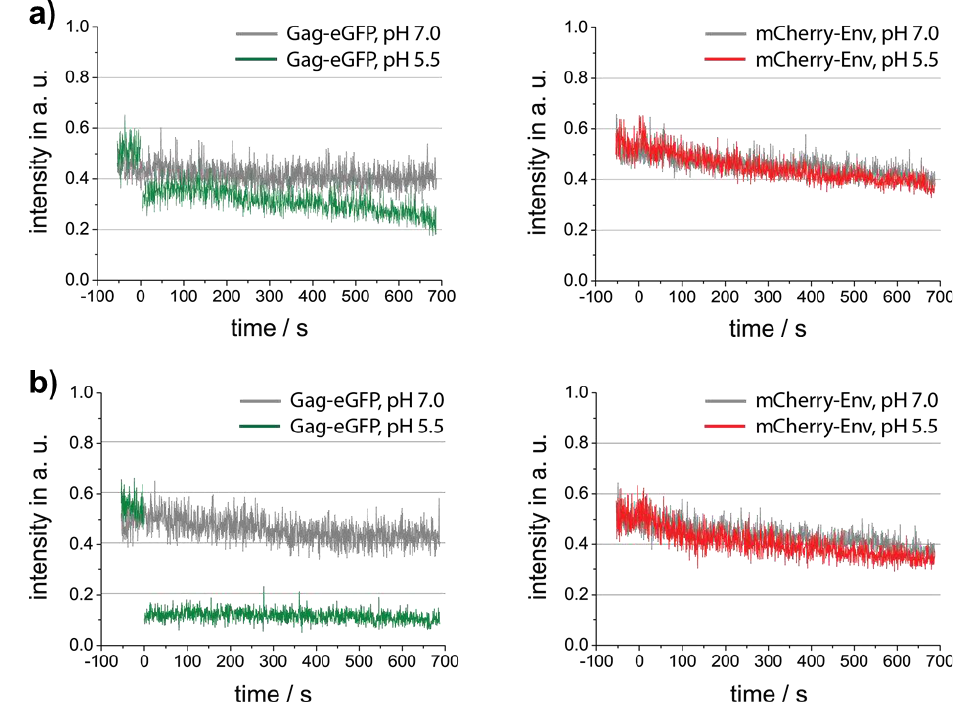
Figure A6. Stability of the fluorescent proteins on dual-color foamy virus particles at different pH values. Intensity traces of double-tagged PFV Env containing particles at pH 7.0 (gray) and pH 5.5 (green). At time point 0, citrate buffer was added to decrease the pH. The background-corrected intensities of ten particles were determined and the average is shown. The intensity of ( a ) intact particles and ( b ) control measurements on fixed and permeabilized particles measured on a coverslip are shwon. Note that the eGFP fluorescence showed a significant drop at pH 5.5.